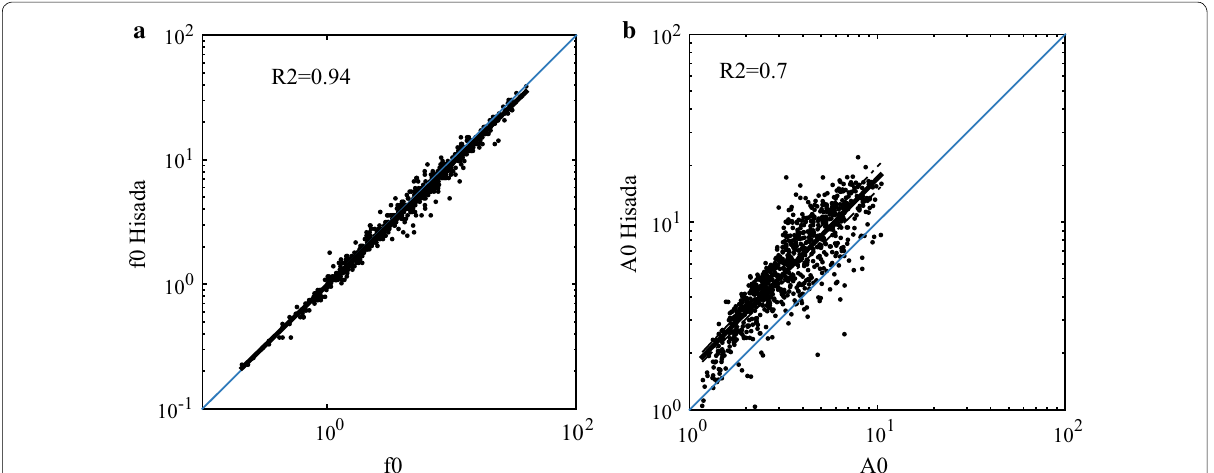
Fig. 7 Statistics of comparison between fundamental frequency f 0T and amplification A 0T derived from 1D SH transfer functions, and estimated values derived from H / V processing of noise synthetics ( f 0HV and A 0HV ). a Frequencies with coefficient of determination R 2 R 2 0.70. The solid blue lines correspond to f 0HV =